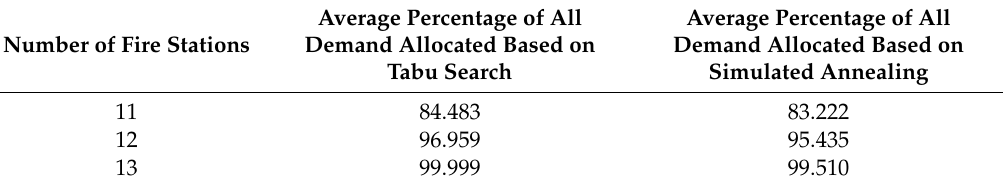
Table 19. The average percentage of all demand allocated using both